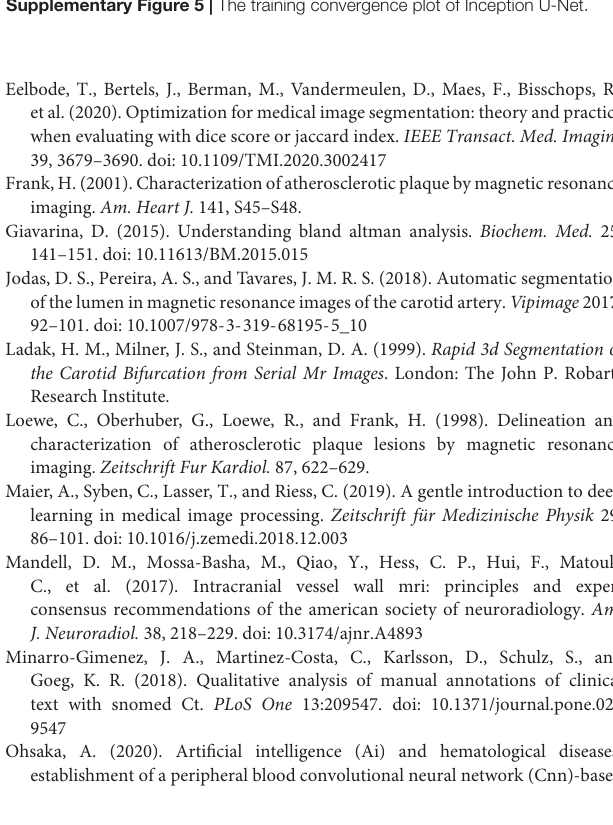
Supplementary Figure 1 | The plot of convergence for training data. Supplementary Figure 2 | The plot of convergence for validation data. Supplementary Figure 3 | The training convergence plot of U-Net. Supplementary Figure 4 | The training convergence plot of Attention U-Net. Supplementary Figure 5 | The training convergence plot of Inception